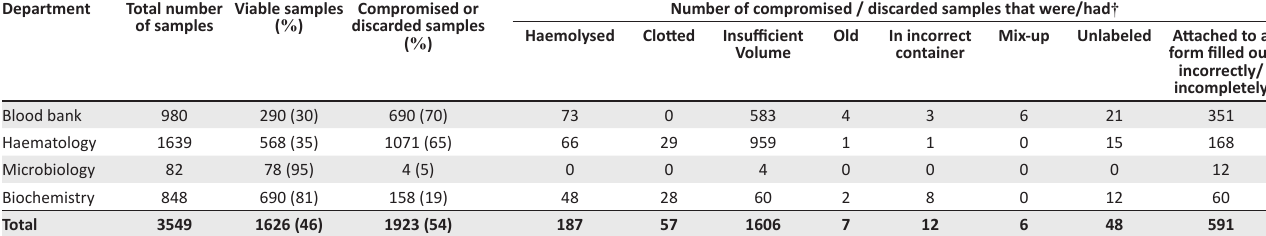
TABLE 1: Results of 2009 quality audit.